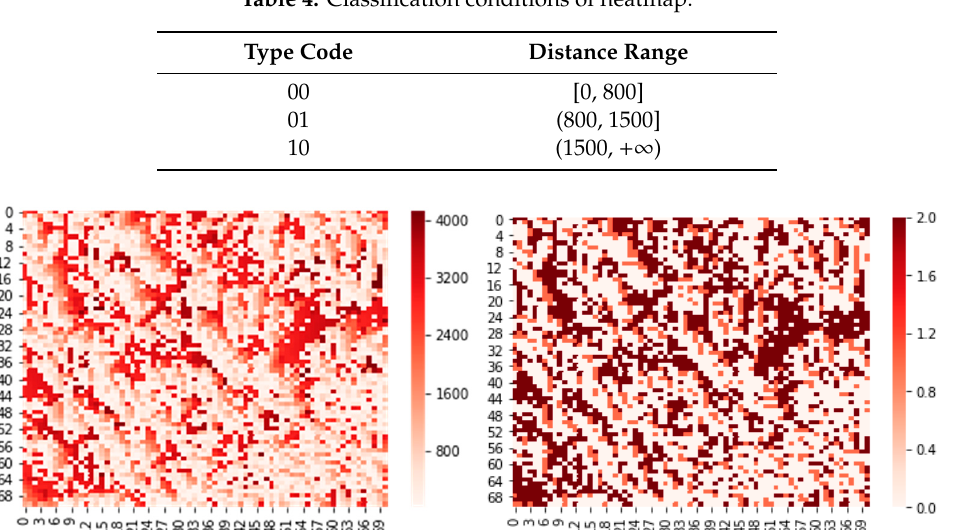
Table 4. Classification conditions of heatmap.